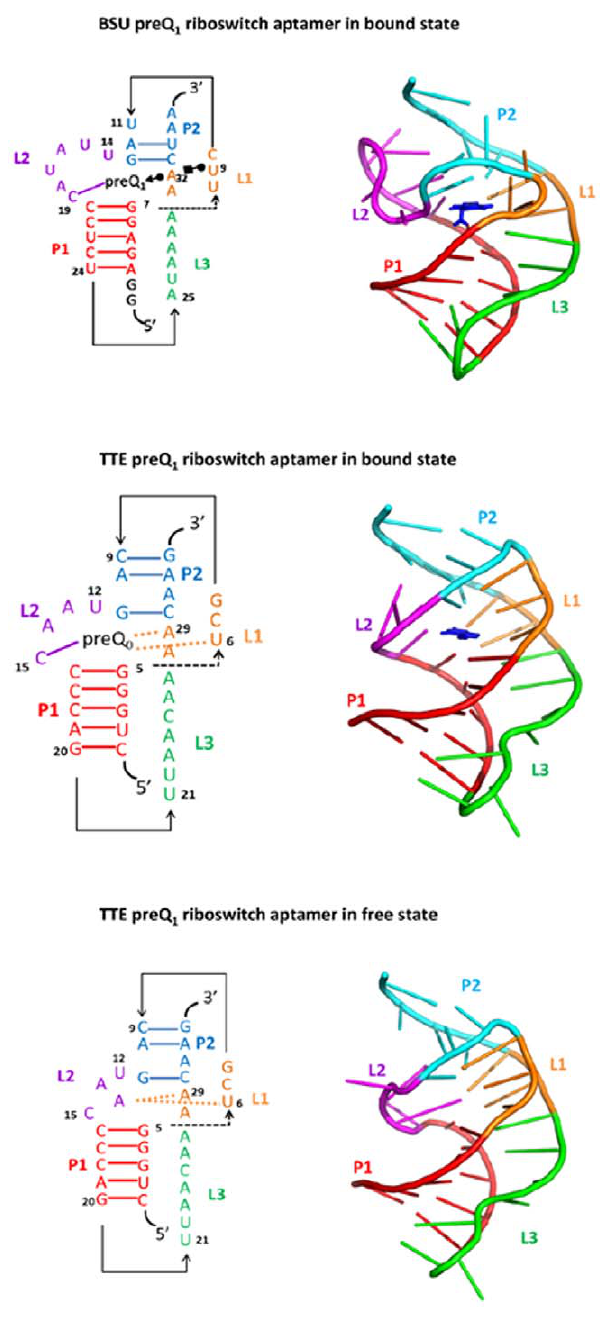
Figure 2. Secondary and tertiary structures of two types of the preQ 1 riboswitch aptamer domains. The bound preQ 1 is depicted by a licorice representation. The different parts (P1, P2, L1, L2, and L3) are color-coded.